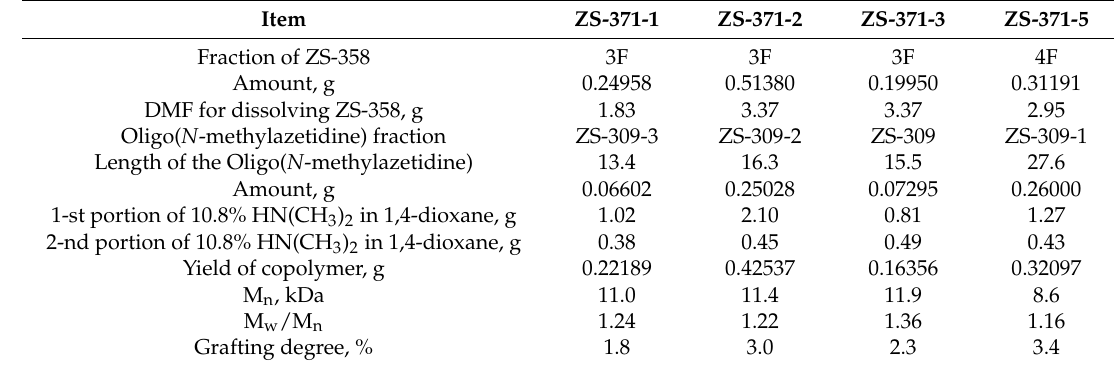
Table 2. Grafting of oligo( N -methylazetidine) onto fractions of ZS-309.